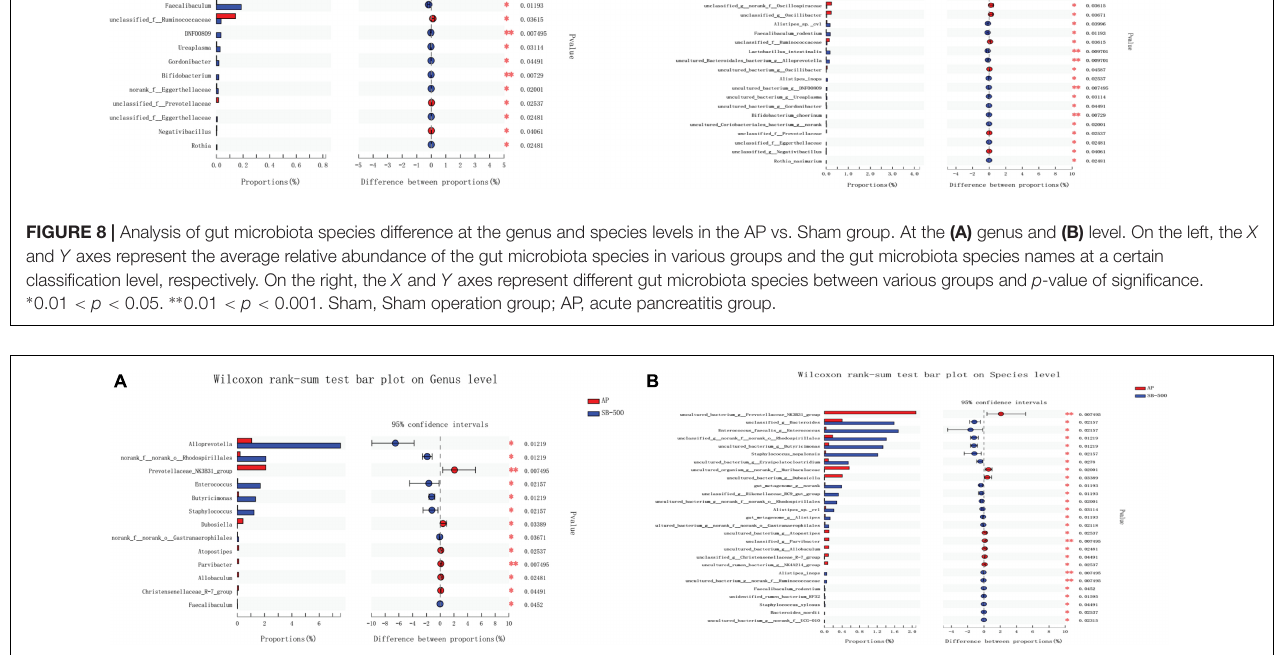
FIGURE 9 | Analysis of gut microbiota species difference at the genus and species levels in the SB-500 vs. AP. At the (A) genus and (B) species level. On the left, the X and Y axes represent the average relative abundance of the gut microbiota species in various groups and the gut microbiota species names at a certain classification level, respectively. On the right, the X and Y axes represent different gut microbiota species between various groups and p -value of significance. ∗ 0.01 < p < 0.05. ∗∗ 0.01 < p < 0.001. AP, acute pancreatitis group; SB-500, 500 mg/kg butyric acid intervention